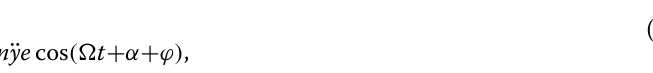
146.2034 kg/s. The diameter of the disc is d p